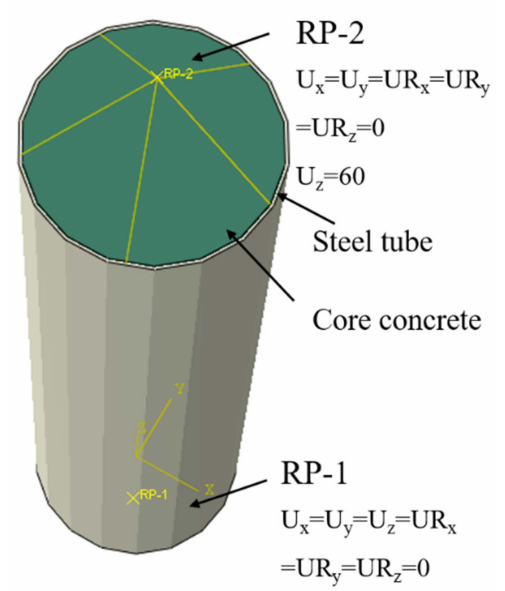
Figure 8. Loading methods and boundary conditions of FEM.